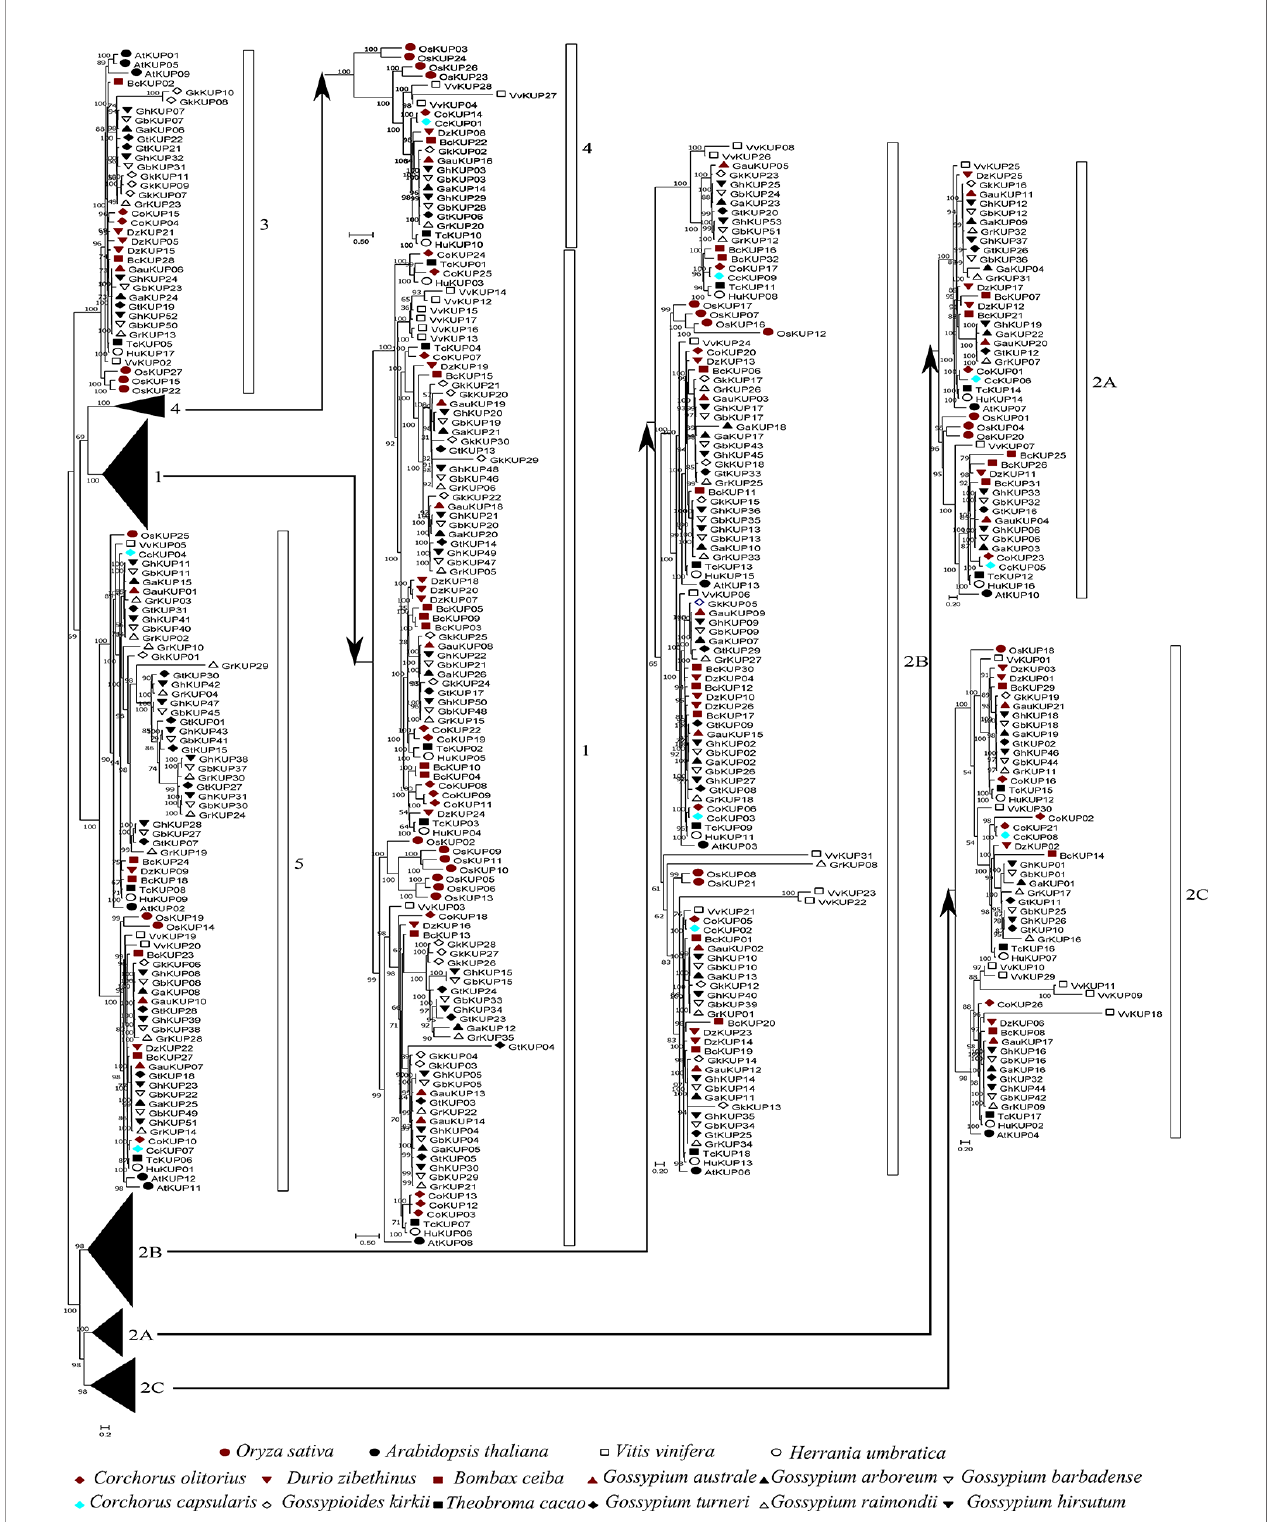
FIGURE 2 | Phylogenetic analysis of the KUP family in 13 Malvaceae species, Arabidopsis , grape, and rice. The phylogenetic tree was constructed via the ML method. Numbers in the clades represent bootstrap values, and KUP subfamilies are indicated by different letters. KUP members from the investigated species are marked by differently colored